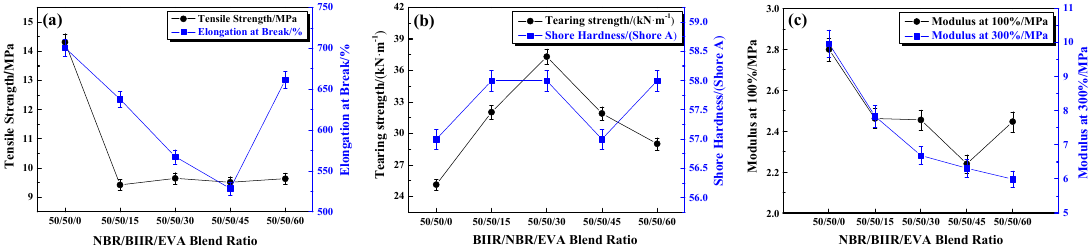
Figure 13. Mechanical properties of NBR/BIIR/EVA with various blend ratios: ( a ) Effect of tensile strength and elongation at break; ( b ) effect of tear strength and shore hardness, and ( c ) effects of 100% and 300% module.